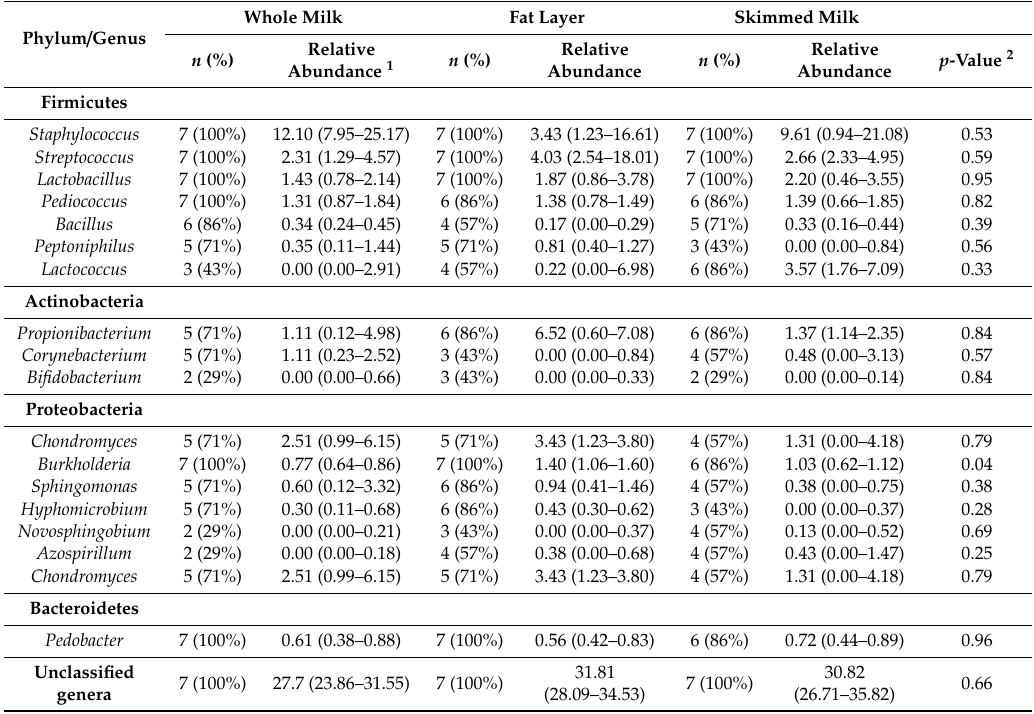
Table 4. Relative abundance of the most abundant genera in the di ff erent milk fractions (whole milk, fat layer and skimmed milk) from milk samples ( n =